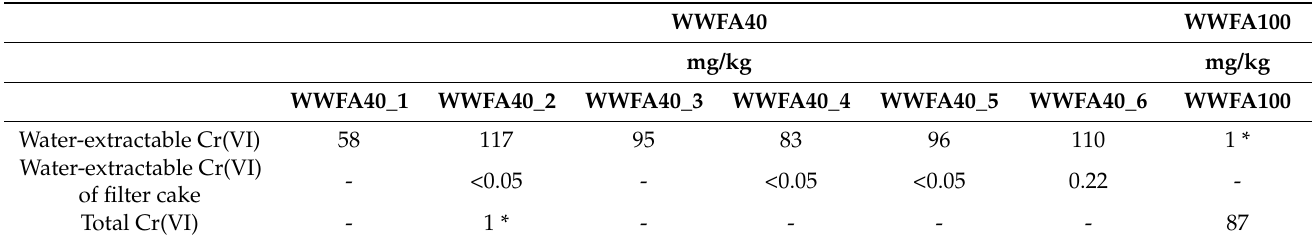
Table 4. Water-extractable Cr(VI) and total Cr(VI) concentrations of WWFA and the filter cakes of WWFA40. Cr(VI) concentrations indicated with * are from extractions with poor Cr(VI) spike recoveries (<2%), implying erroneously low values. Where not indicated, the Cr(VI) spike was fully